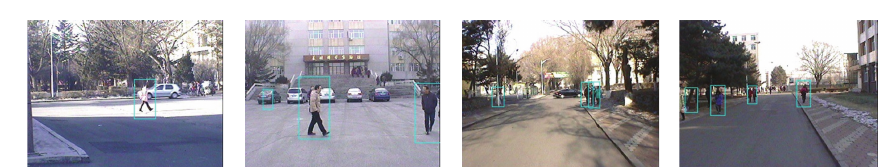
Figure 10: Pedestrian candidate region estimation results under di ff erent urban scenarios.